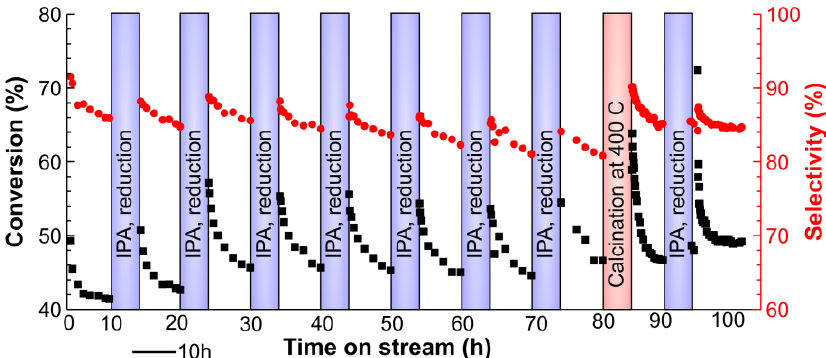
Figure 11. The stability test of the 2 m tube reactor coated with a 12 wt % Pt/SiO 2 catalyst. Reaction conditions: H 2 flow rate: 3 mL min − 1 , liquid flow rate: 0.2 mL min − 1 , CAL concentration: 0.8 M in IPA, pressure: 15 bar and temperature: 150 ◦ C. Reduction was performed in the flow of